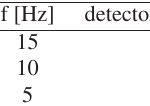
Table 1. Simulated frequencies and corresponding velocity